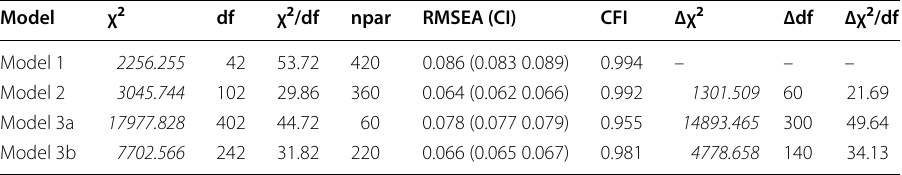
Table 4 Fit indices for multiple-group CFAs of the four-item scale for different levels of measurement